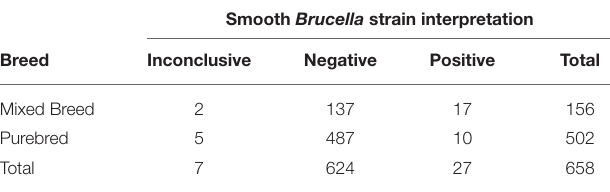
TABLE 6 | Breakdown of smooth strain interpretation by breed (retrospective samples).